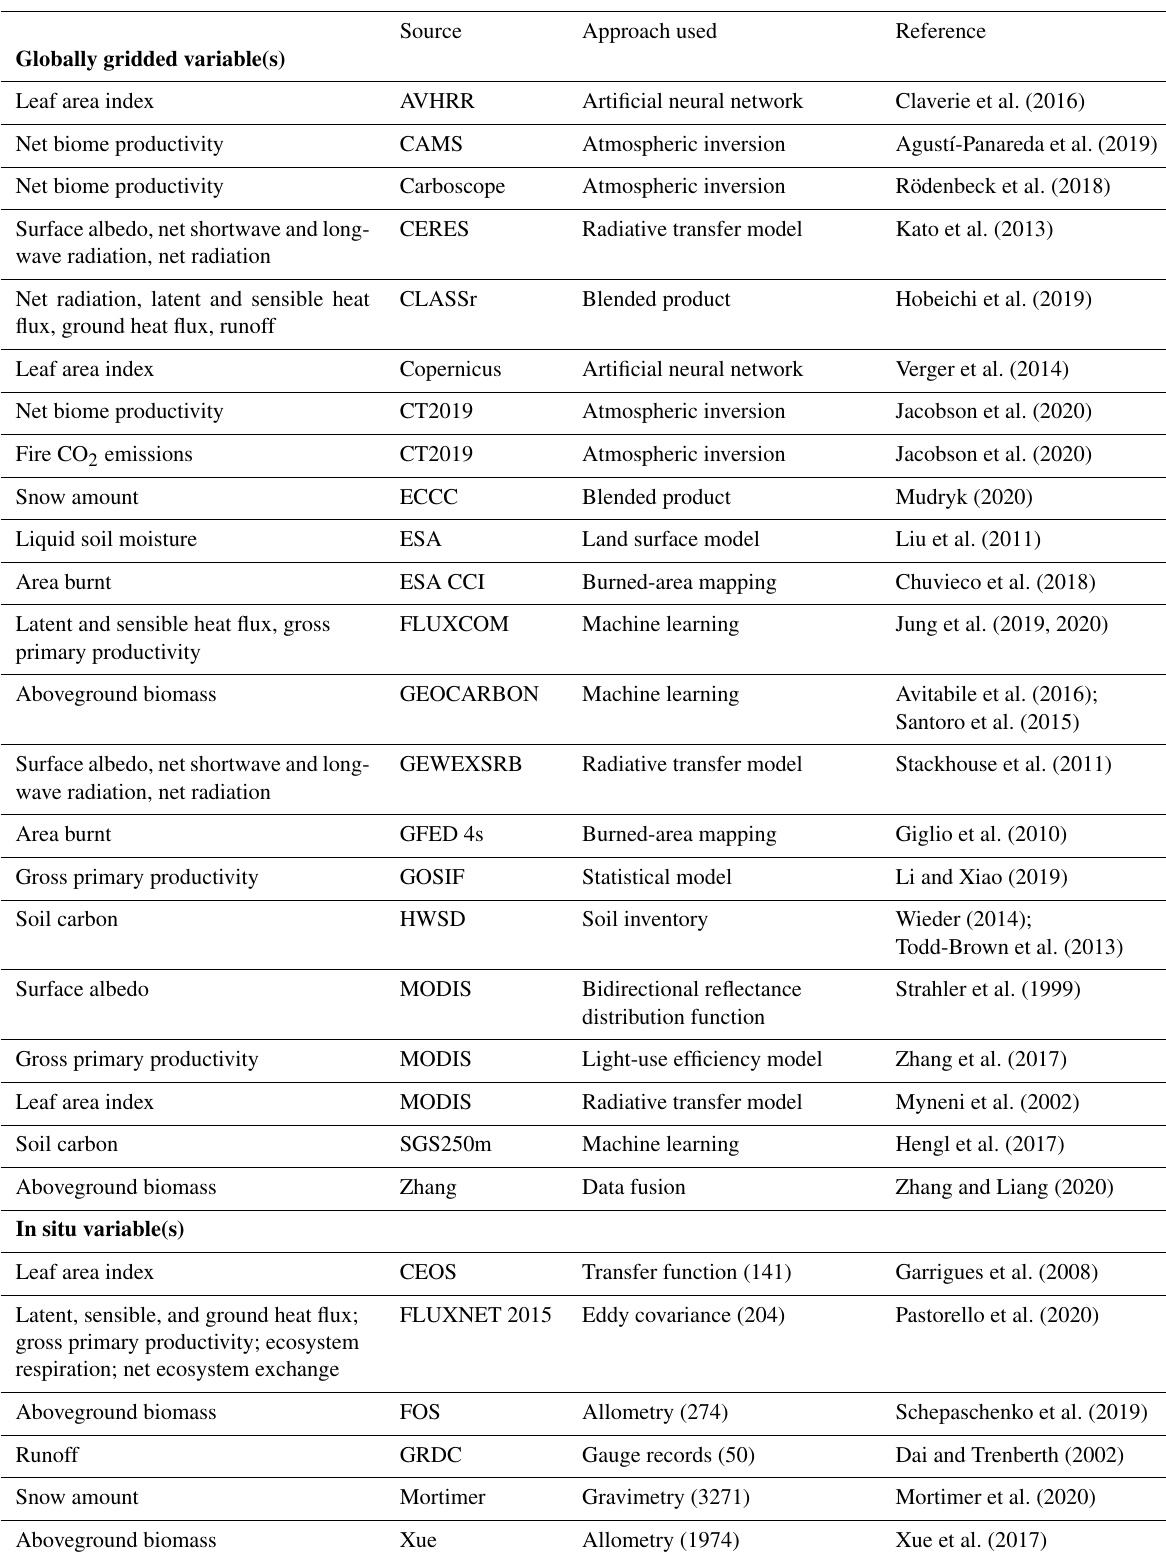
Table 2. Observation-based data sets used for model evaluation in